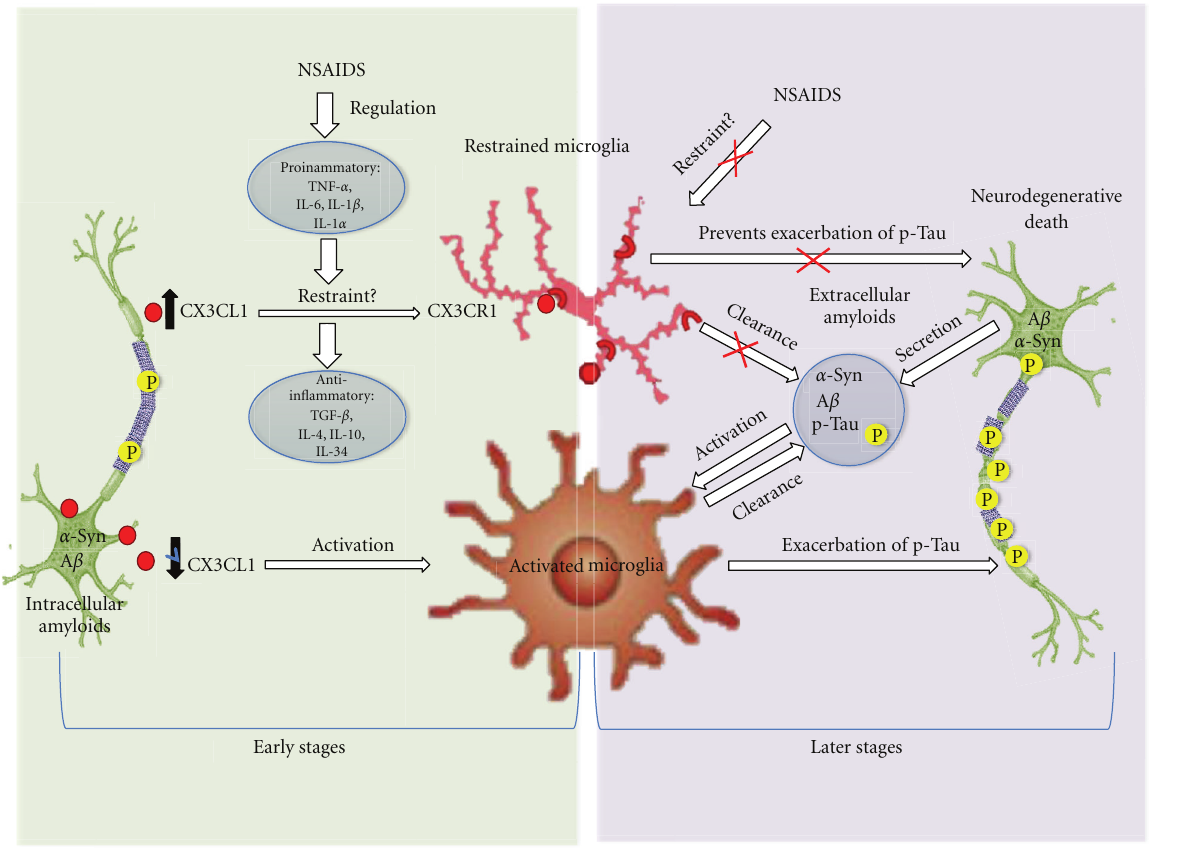
Figure 2: Modulation of CX3CL1 in early versus late disease stages. The success of anti-inflammatory treatment in neurodegenerative diseases likely depends on the stage of disease progression. Treatment with NSAIDS early in disease pathology may alter the levels of various proinflammatory markers, including TNF- α , IL-6, IL-1 β , and IL-1 α , and anti-inflammatory markers, including TGF- β , IL-4, IL-10, and IL-34. The changes in the levels of these cytokines may lead to altered CX3CL1 signaling, which would either increase microglial activity (if CX3CL1 were reduced) or restrain microglia (if CX3CL1 levels were increased). In later stages of disease, secretion of pathogenic proteins like A β , α -synuclein, and p-Tau to the extracellular space increases microglial activation. Microglial activity promotes p-Tau, which destabilizes microtubules and leads to cell death. Treatment with NSAIDS in later stages of disease would likely be detrimental, as restraining microglia would weaken the immune response to remove extracellular protein